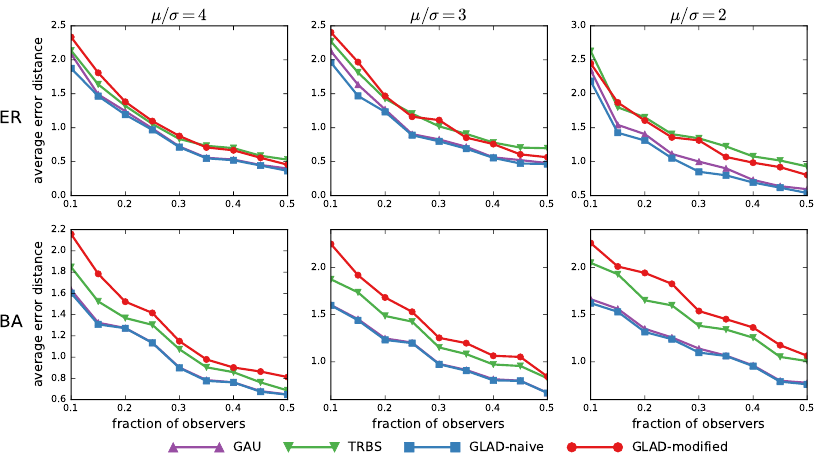
Figure 4. Average distance between the estimated source and the real source in different source localization algorithms on synthetic trees. If more than one node is ranked first, we randomly choose one as the estimated source.